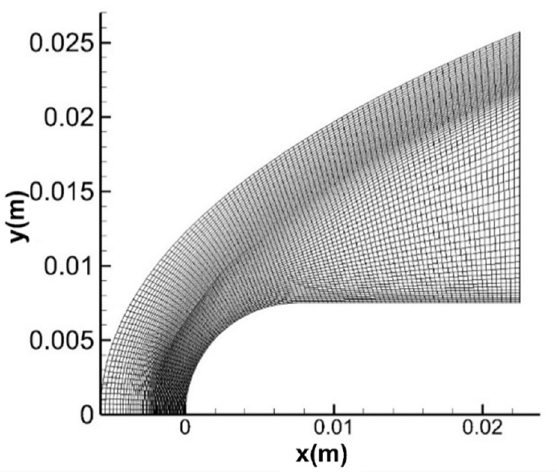
Figure 11. Structured mesh for shock-induced sub-detonative combustion calculation. Table 7. Flow conditions of shock-induced sub-detonative combustion.